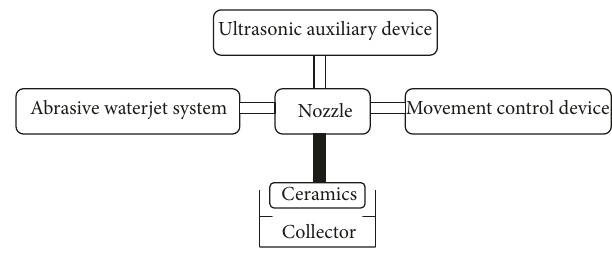
Figure 1: The sketch of experiment scheme.